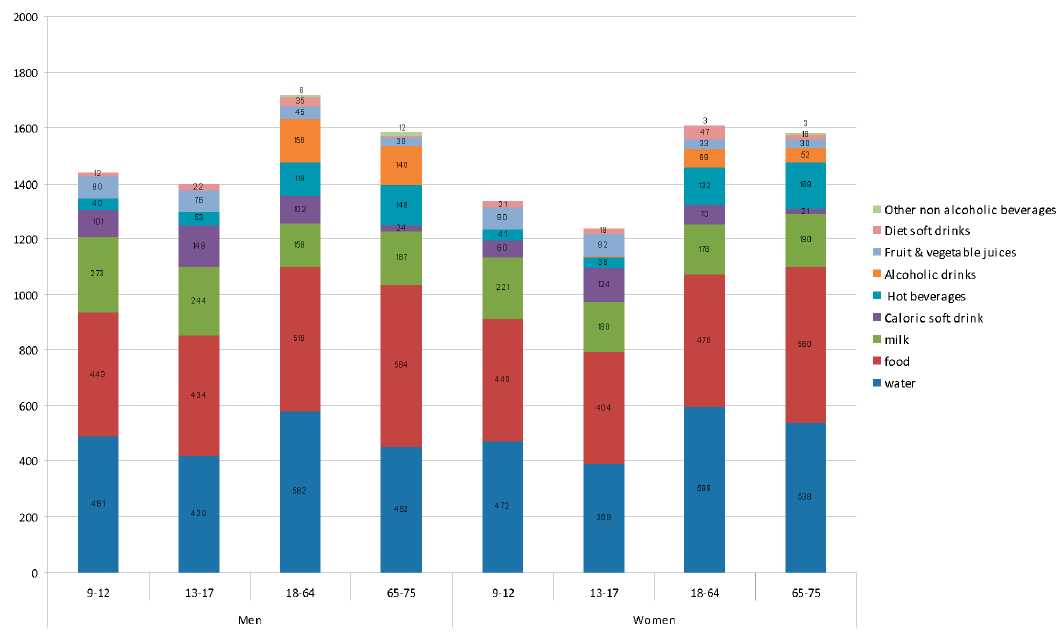
Figure 3. Daily Water intakes (g/day) from beverage/food categories by age and gender among ANBIES population.